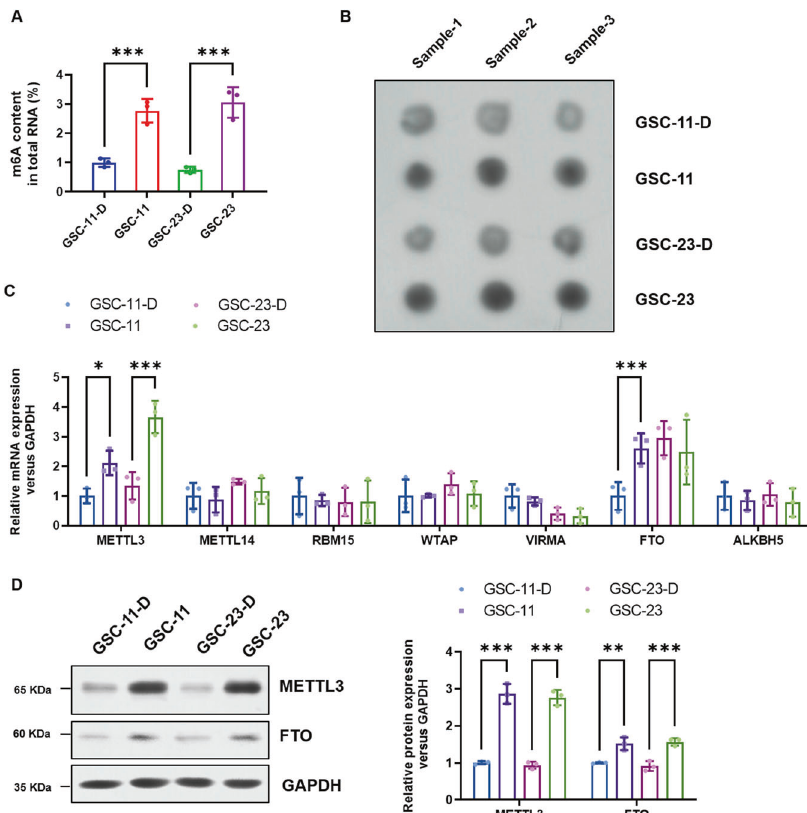
Fig. 1 Both total m6A RNA modi fi cation and METTL3 expression of GSCs were signi fi cantly higher than those of the corresponding differentiated cells. A The colorimetric m6A quanti fi cation assay was conducted to examine the total m6A levels of two GSCs cell lines and the corresponding differentiated GSCs. B Dot Blot was performed to con fi rm the total m6A levels of two GSCs cell lines and differentiated GSCs. C The mRNA expression level of major m6A methyltransferases (METTL3, METTL14, RBM15, WTAP, and VIRMA) and demethylase (FTO and ALKBH5) of both two GSCs cell lines and their differentiated cells were analyzed by real-time PCR. D The dys-regulated level of METTL3 and FTO was con fi rmed by Western Blotting. * P ＜ 0.05, ** P < 0.01 and *** P < 0.001 versus indicated